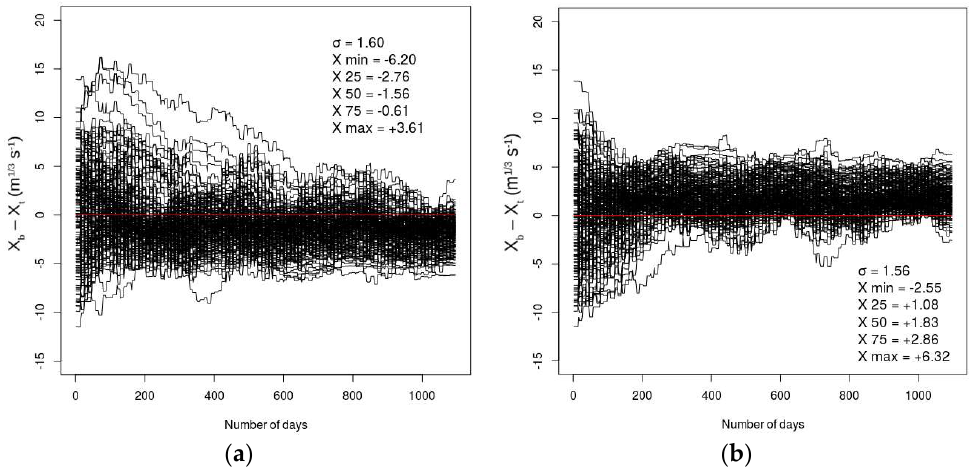
Figure 8. Temporal evolution (1 August 1995 to 31 July 1998) of the difference between the a priori control vector (x b ) and the true control vector (x t ) of the Strickler coefficients in the DA system. Scenario ( a ) represents a − 10% perturbation of water produced by ISBA, and scenario ( b ) represents a +10% perturbation. The 165 black curves represent the value (x b − x t ) of all 165 reaches defined over the Garonne catchment. The red horizontal line is equivalent to a zero difference between x b and x t . After 3 years (i.e., 548 48 h-assimilation windows), we represent the standard deviation, σ xb , between the 165 values (x b − x t ) in the basin. The X terms represent from top to bottom the minimum value, the 1st quartile, the 2nd quartile, the median, the 3rd quartile, and the maximum value of (x b − x t ) at the end of the experiment (day n° 1096).